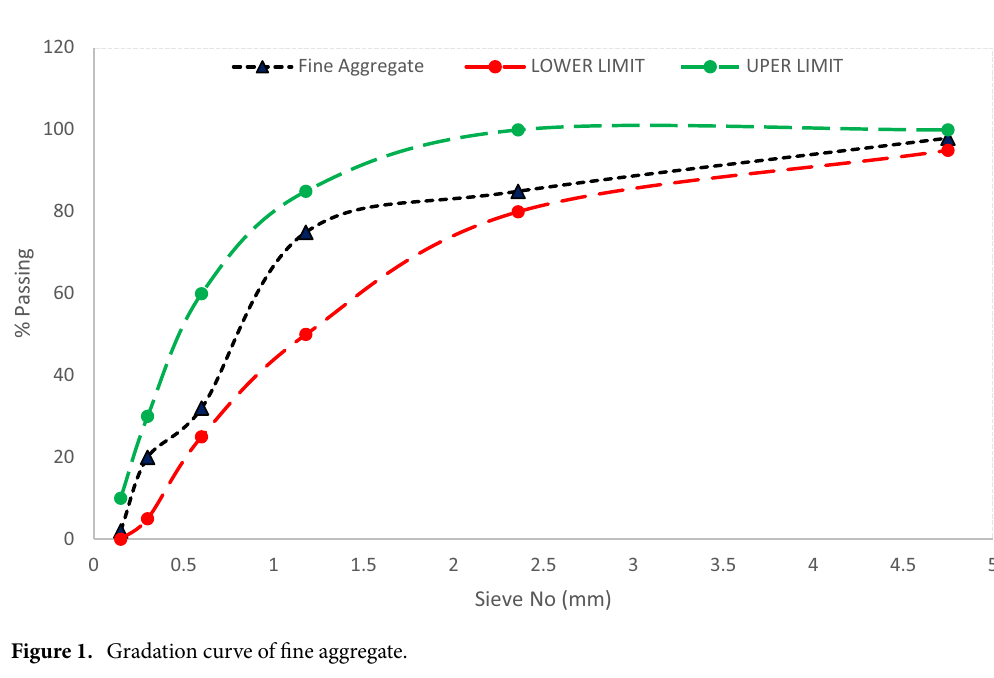
Figure 1. Gradation curve of fine